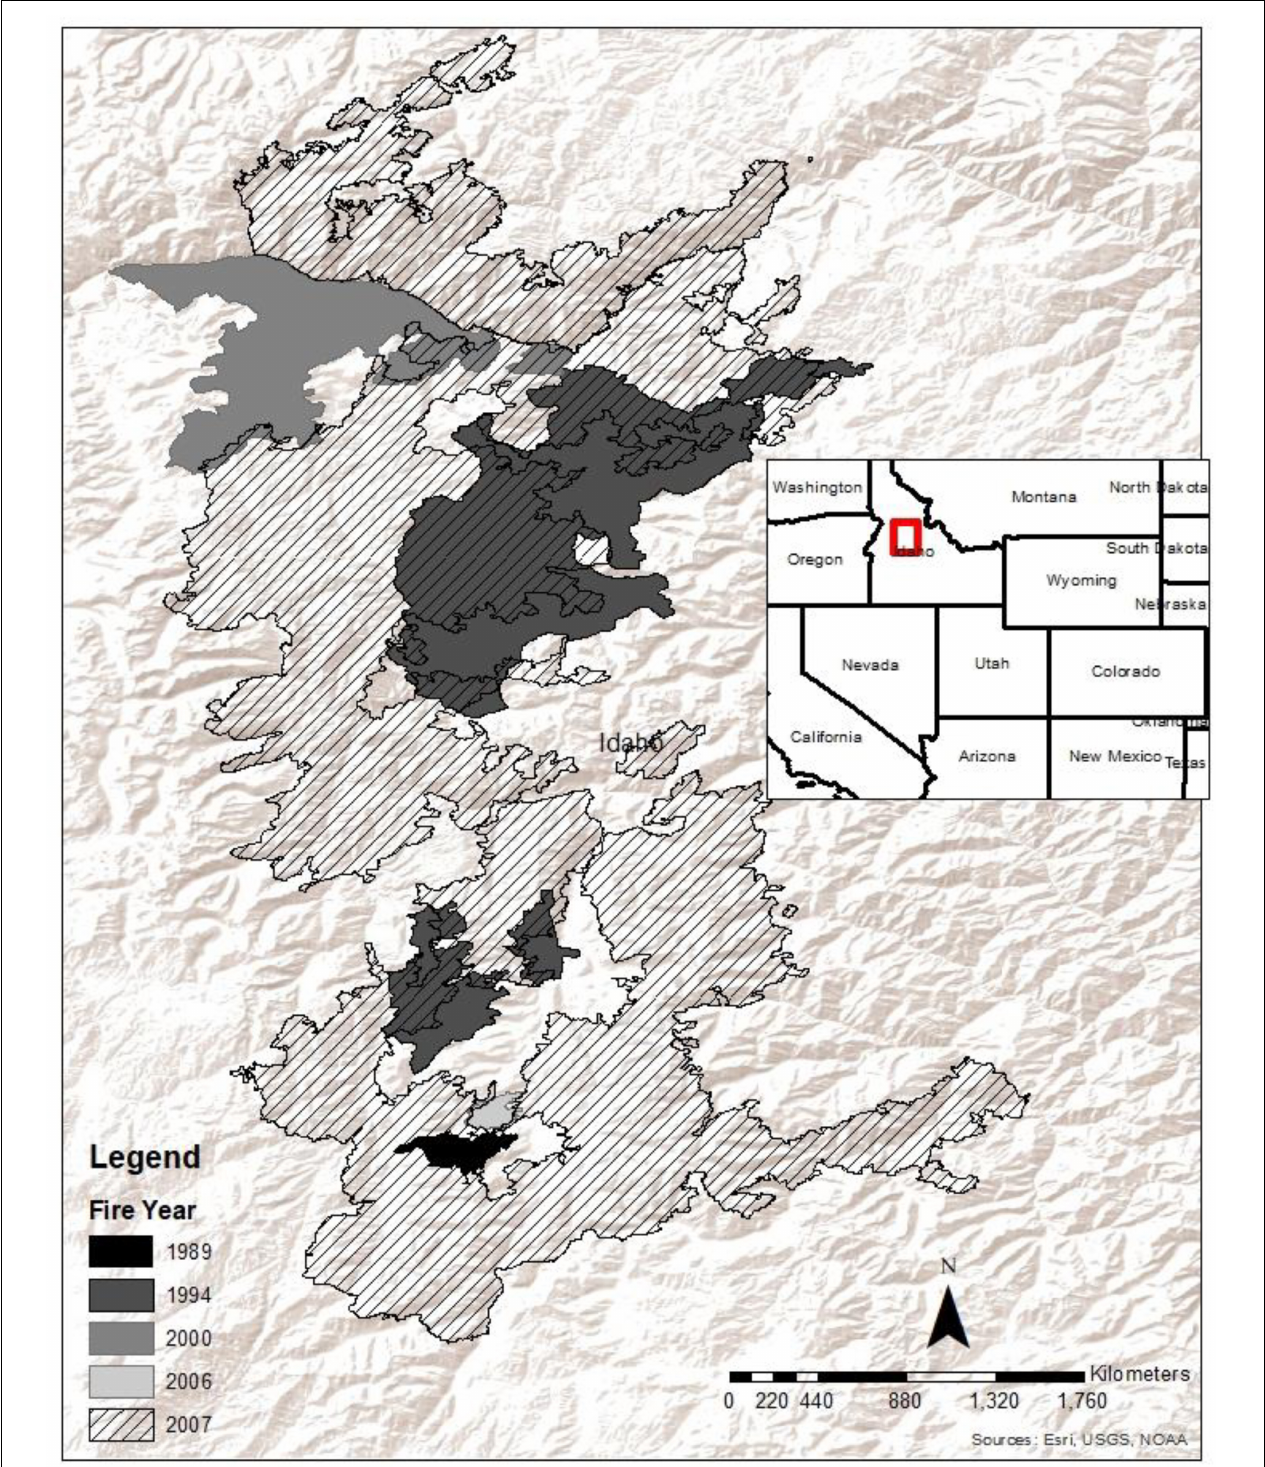
FIGURE 1 | Gray-scale perimeters indicate burn areas we sampled in Idaho, United States. These large fires burned between 1989 and 2007 according to the MTBS database (http://www.mtbs.govmtbs.gov).